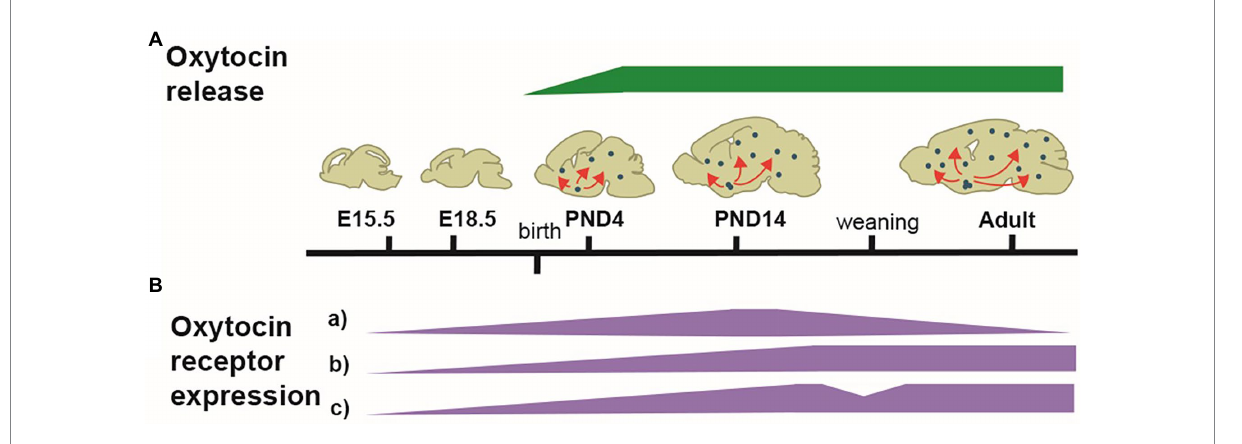
FIGURE 1 Illustration of the developmental dynamic of the OT-system. (A) Schematized patterns of OT produced in the hypothalamus and released in the forebrain (green). OT is first released at birth. (B) Schematized patterns of OTR expression (purple). From E14.5, OTRs progressively appear in several brain regions, with different dynamic patterns of expression. In many areas, OTRs pick between PND14-PND21, followed by either a decline (a) or a stabilization (b); in some areas, a reshaping of OTRs expression occurs at weaning, with a disappearance from some areas and an increase in others (c). The adult pattern of OTR expression is achieved at